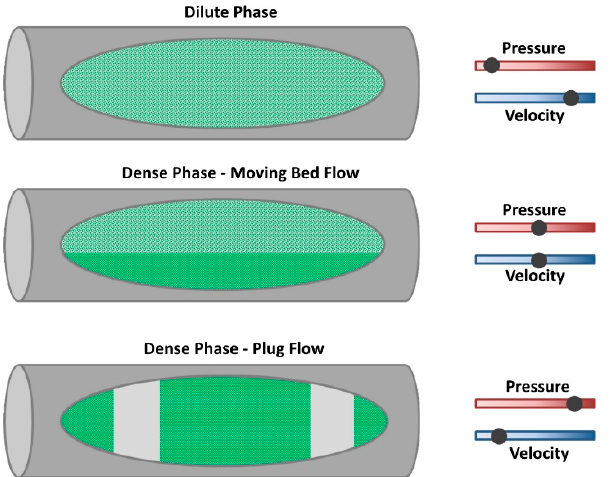
Figure 13. Dilute vs dense phase flow—https://www.ddpsinc.com/knowledge/are-there-different- types-of-pneumatic-conveying-systems (accessed on 7 May 2019).